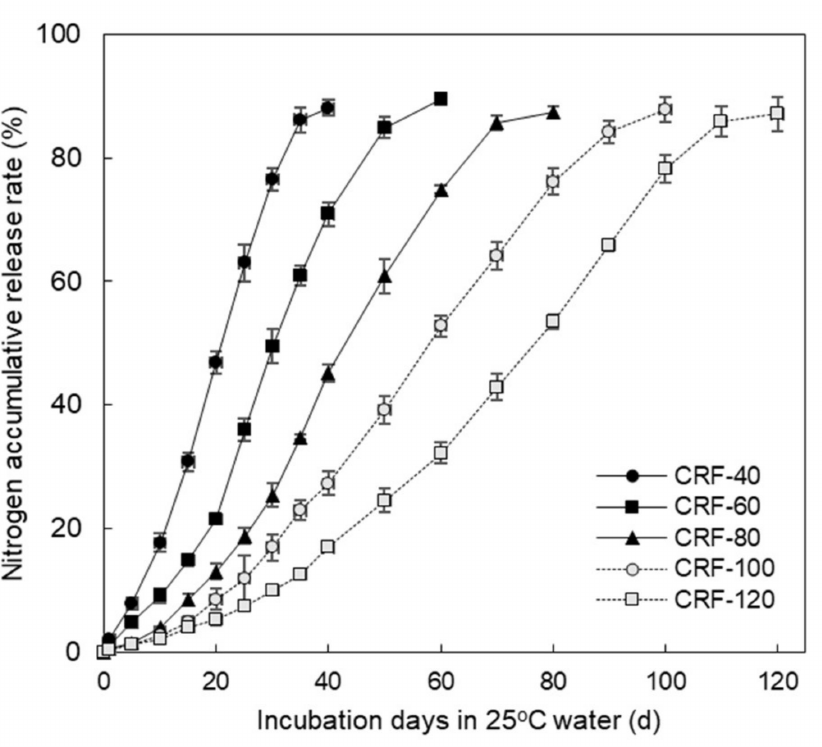
Figure 2. Cumulative nitrogen release rates of the CRUs at 25 ◦ C in water. CRF-40, CRF-60, CRF-80, CRF-100 and CRF-120 were controlled released fertilizers with expected controlled release times of 40, 60, 80, 100 and 120 days,